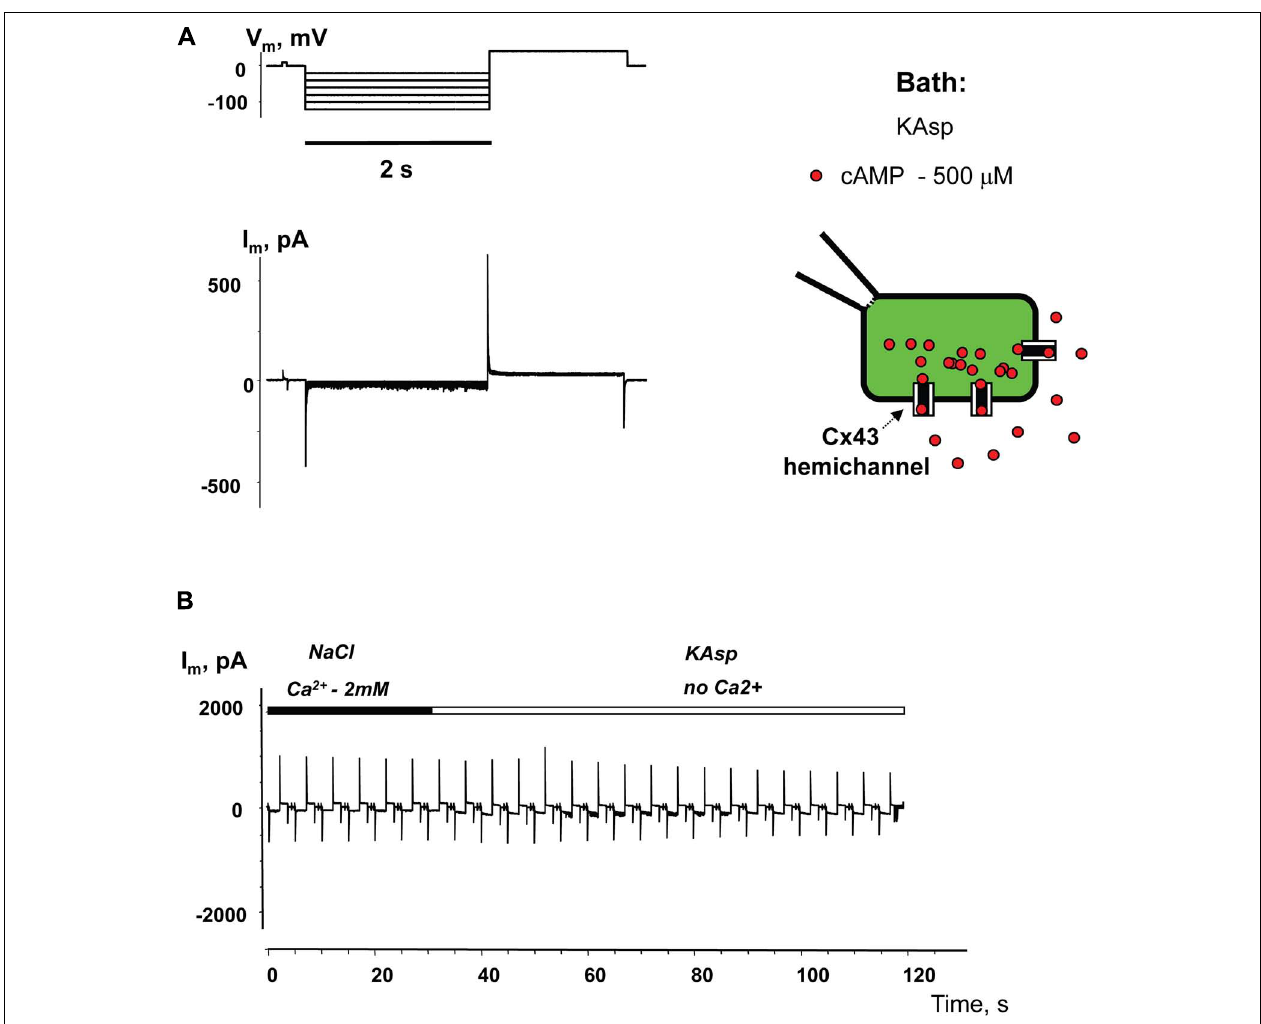
FIGURE 5 | Membrane currents without SpIH expression. (A) I m responses from HeLaCx43 cell lacking expression of SpIH to hyperpolarizing pulses recorded in Ca 2 + -free KAsp solution. (B) Perfusion with the Ca 2 + -free KAsp external solution did not induce currents in HeLaCx43 cells that were